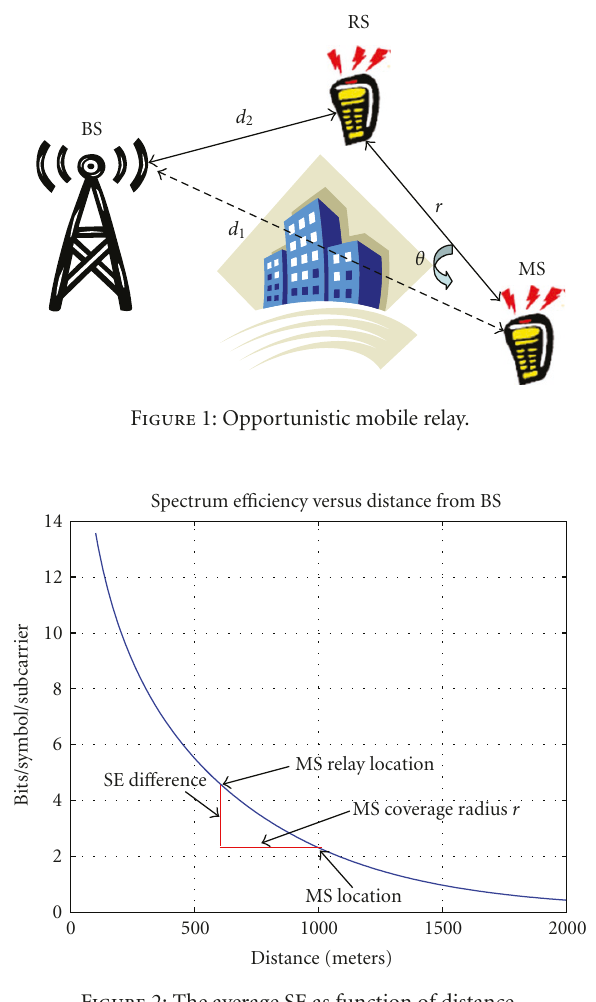
Figure 2: The average SE as function of distance.